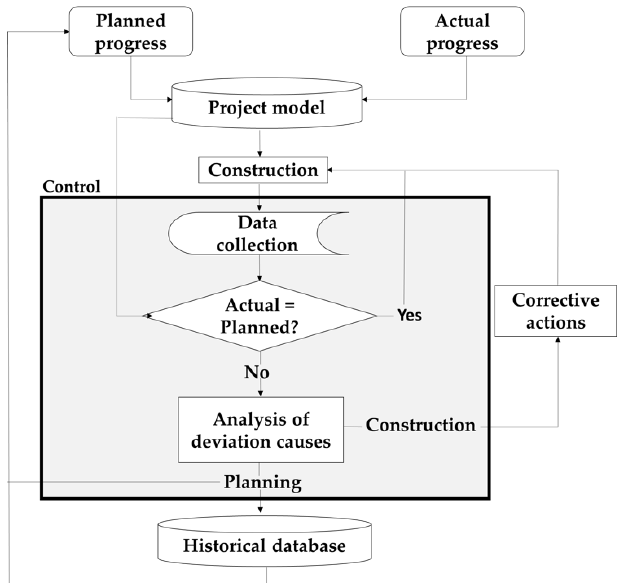
Figure 1. Schematic of model for real-time closed loop control. Adapted from [22].